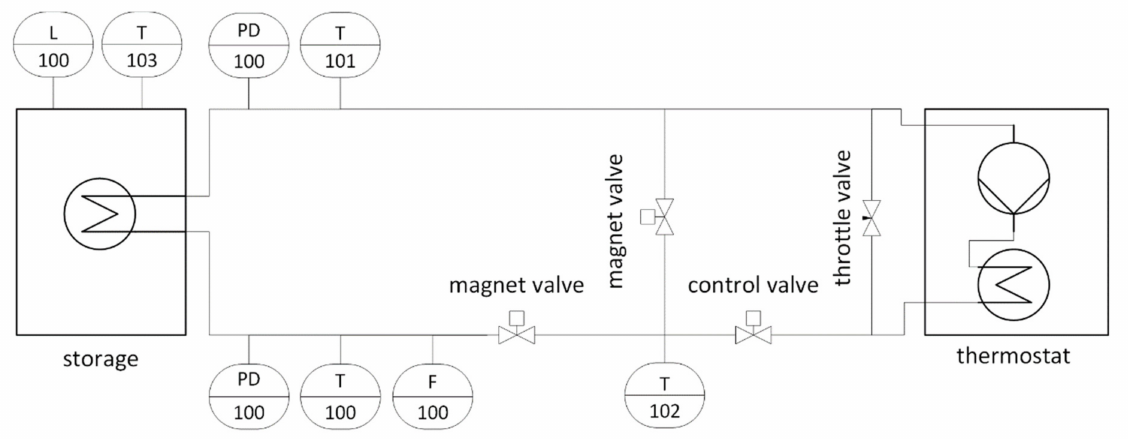
Figure 6. Flow chart of test